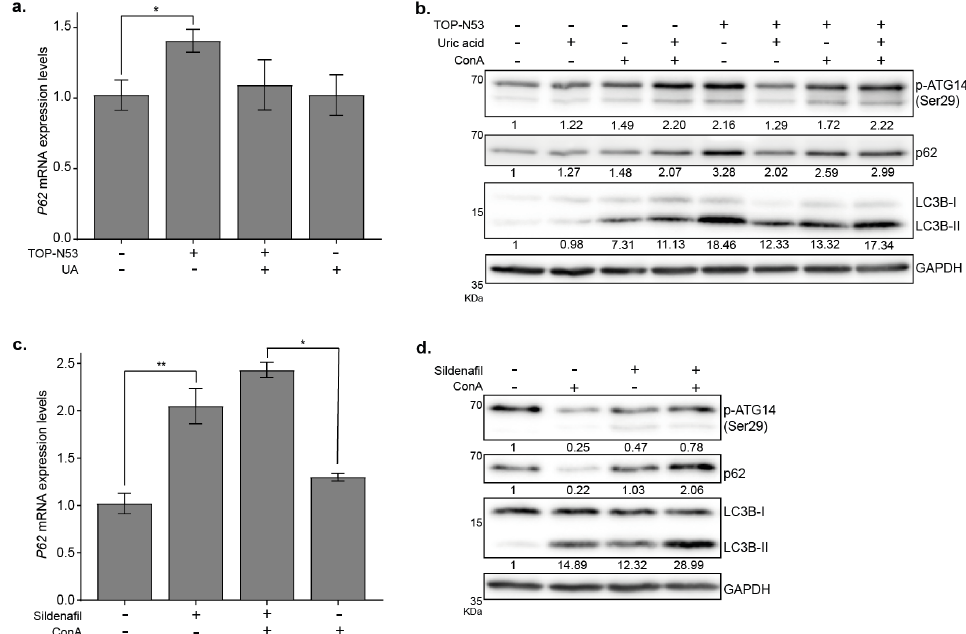
Figure 5. TOP-N53 induces autophagy in NHFs by its dual mechanism of action. ( a ) P 62 mRNA levels in NHF upon TOP-N53 treatment (1 μ M, 6 h) in presence or absence of uric acid (UA, 40 mg/L, 6 h). Data were normalized to HPRT 1 levels and are represented as mean ± s.e. ( n = 3). * p ≤ 0.05 using one-way ANOVA with a Holm–Sidak test post-hoc analysis. ( b ) Analysis of the autophagic flux in NHFs upon treatment with TOP-N53 (1 μ M, 24 h) in presence or absence of UA (40 mg/L, 24 h) and ConA (2.5 nM, 2 h). Representative Western blot ( n = 2) and its densitometric quantification below each protein panel (normalized to GAPDH). ( c ) P 62 mRNA levels in NHF upon Sildenafil treatment (100 μ M, 6 h) in presence or absence of ConA (2.5 nM, 2 h). Data were normalized to HPRT 1 levels and are represented as mean ± s.e. ( n = 3). * p ≤ 0.05 and ** p ≤ 0.01 using one-way ANOVA with a Holm–Sidak test post-hoc analysis. ( d ) Analysis of the autophagic flux in NHF upon treatment with Sildenafil (100 μ M, 24 h) in presence or absence of ConA (2.5 nM; 2 h). Representative Western blot ( n = 2) and its densitometric quantification below each protein panel (normalized to GAPDH).